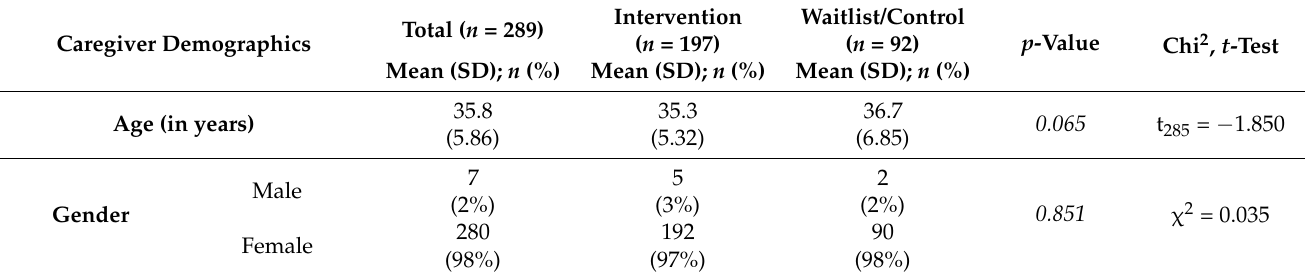
Table 1. Demographic characteristics of study participants within the intervention and waitlist/control